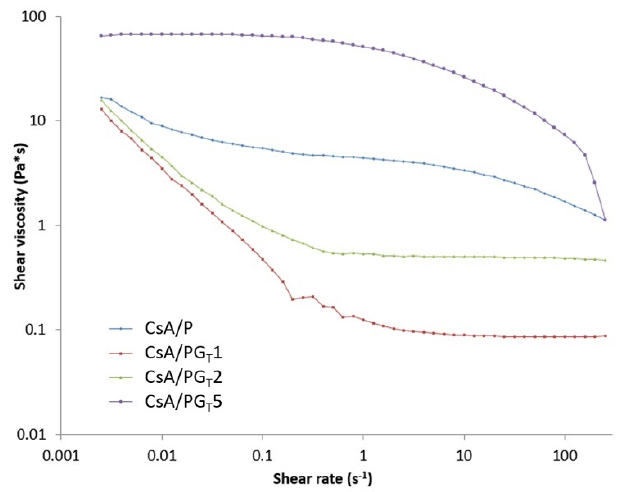
Figure 3. Flow curves registered for the prepared precursor systems .